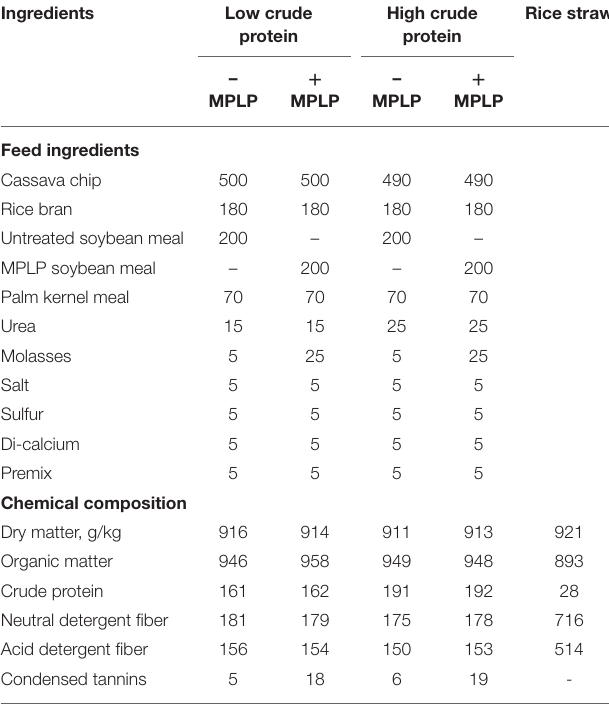
TABLE 1 | Chemical composition of concentrate and rice straw used in the